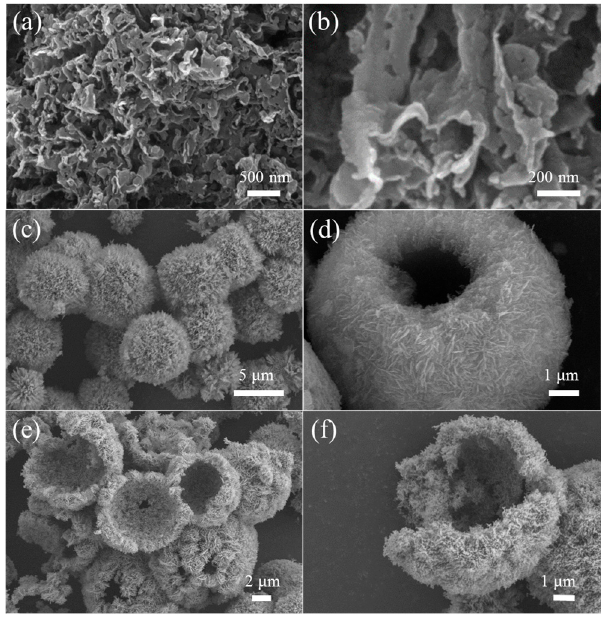
Figure 5. FESEM images of g-C 3 N 4 ( a , b ), the precursor of CNZO-8 ( c , d ), and the CNZO-8 annealed at 400 ◦ C ( e , f